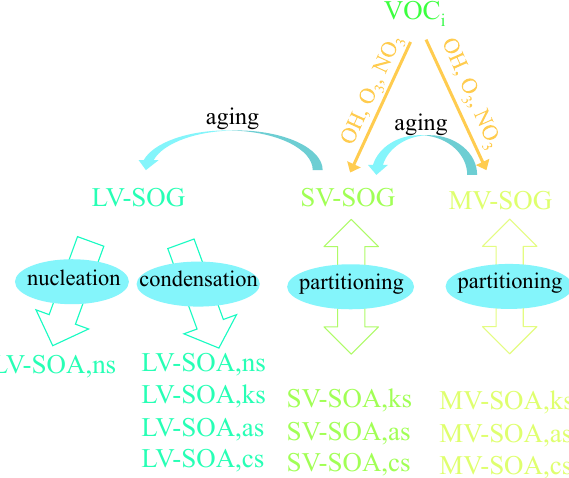
Fig. 1. Schematic illustration of SOA particle formation and ox- idation aging processes. VOC i : precursor gases; SOG: secondary organic gas; SOA: secondary organic aerosol; LV: low volatile; SV: semi-volatile; MV: medium volatile; ns: nucleation mode soluble; ks: Aitken mode soluble; as: accumulation mode soluble; cs: coarse mode